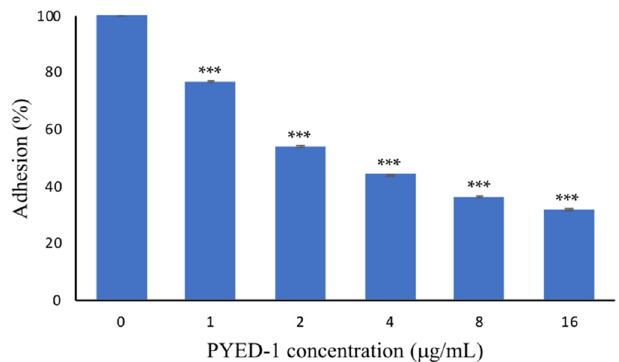
Figure 4. The adhesion of C. albicans with the addition of different concentrations of PYED-1. The adhesion was measured after 90 min of addition of PYED-1 by CV staining. All experiments were performed in triplicate. Asterisks indicate a statistically significant difference (*** p -value ≤ 0.001 from the nontreated controls without PYED-1).